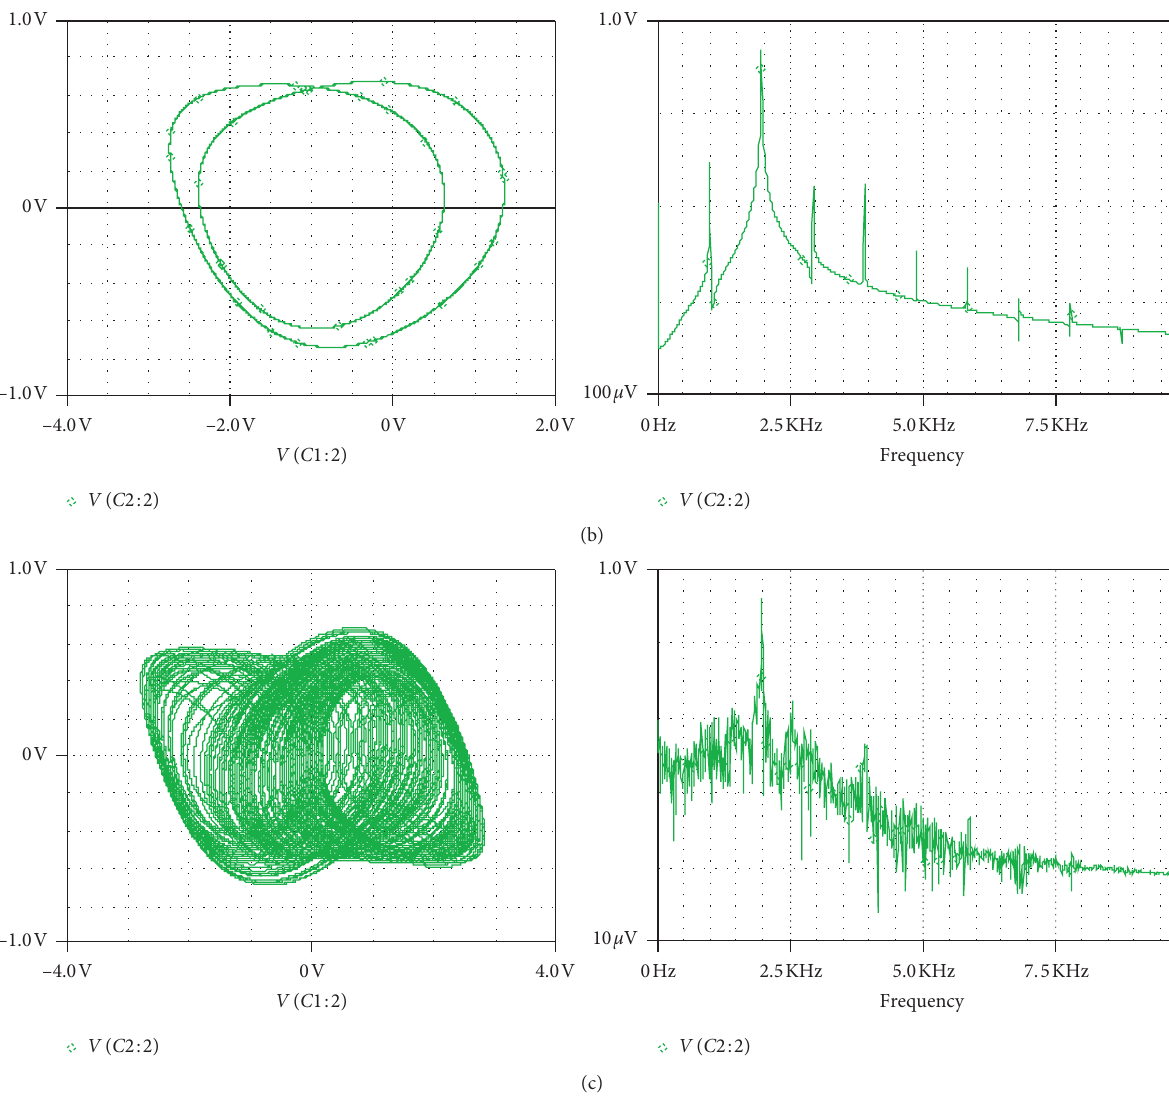
� 2 . 1438 V, (b) for V � − 2 . 1438V, and (c) for V � 0V. Parameter ε ε ε